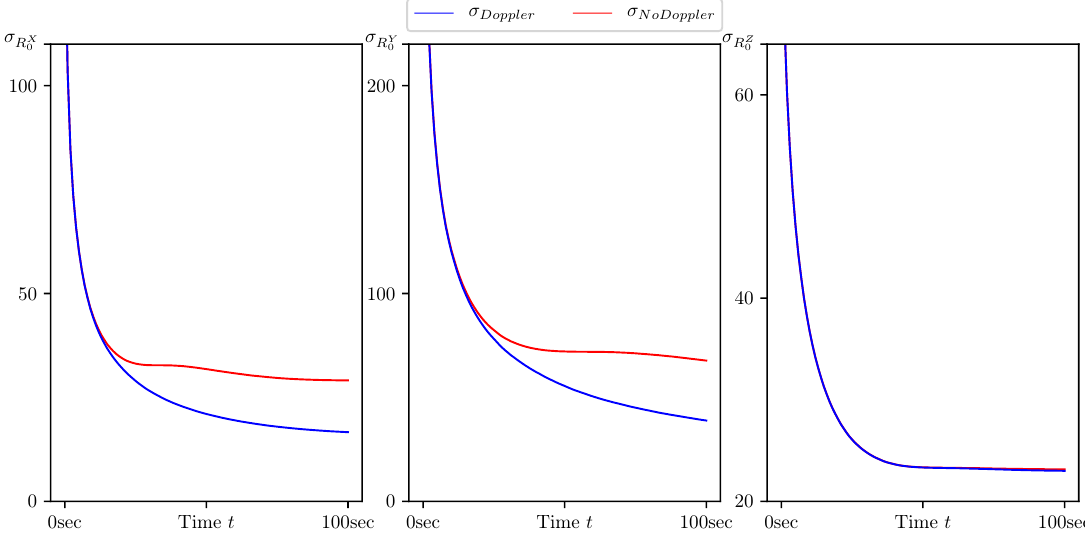
) T , R Y , R Z 0 0 0